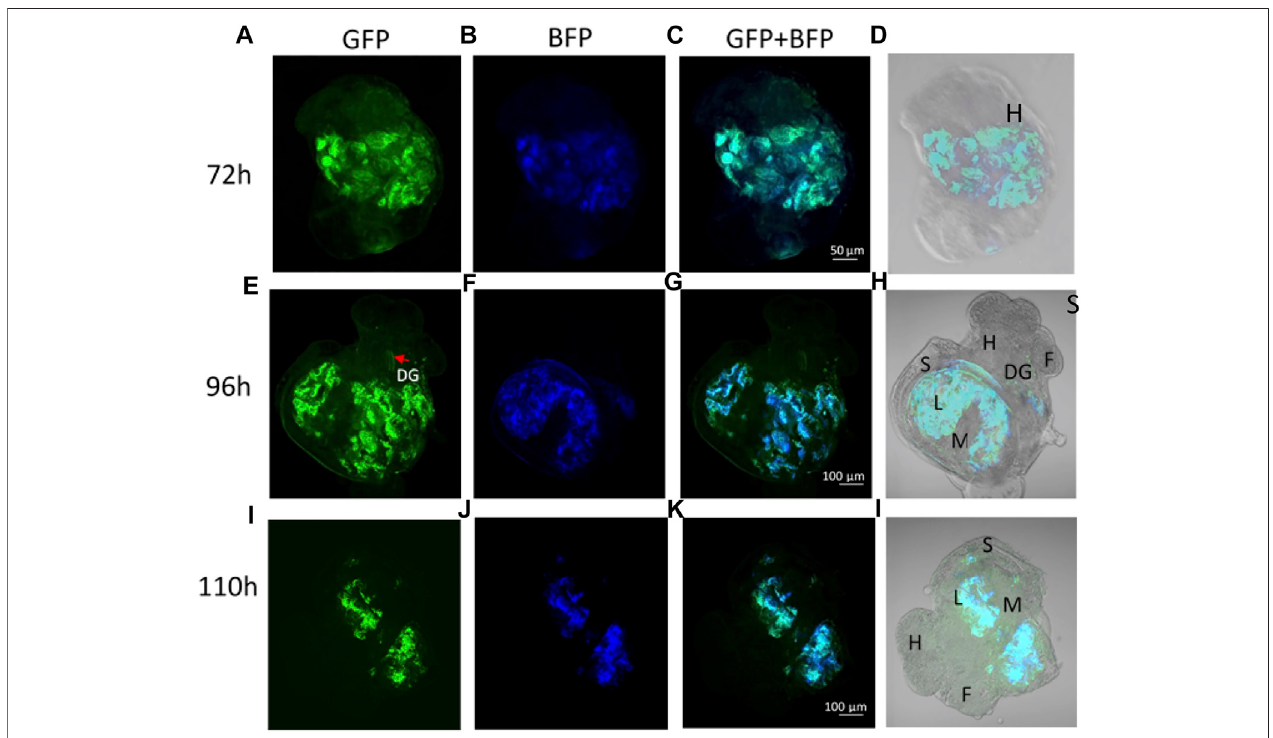
FIGURE 2 | (A – D) Trocophore larva 72 h post transfection with dCas9-SunTag-BFP and scFv-DNMT3A plasmids. (A) GFP expression, (B) BFP expression, and (C) GFP and BFP co-localization. (E – H) Veliger larva 96 h post transfection. (I – L) Snail in hippo stage 110 h post transfection. Anatomical annotations: H-head, F-foot, S-shell, L-lung, M-mantle, DG-digestive